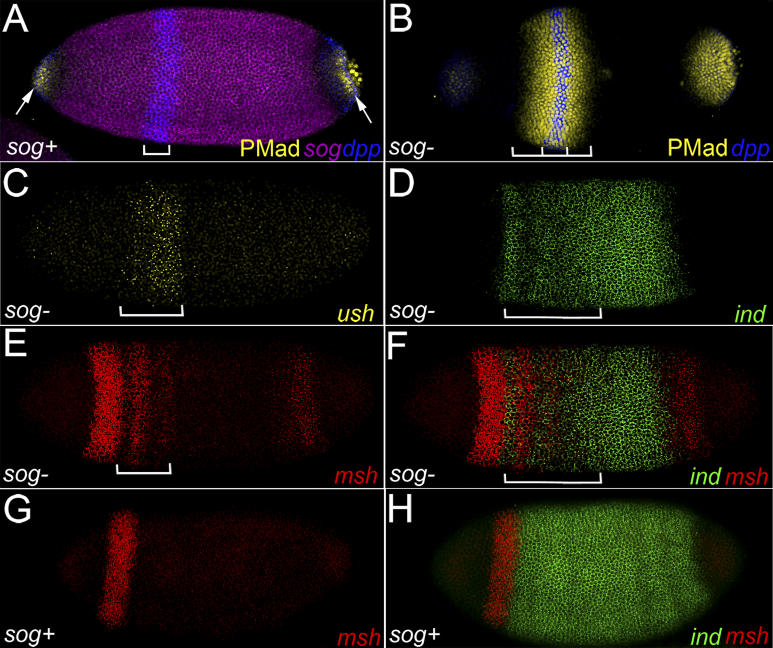
Threshold-Dependent Repression of ind and msh in Lateralized Embryos(A) sog (purple), dpp (blue), and pMAD (yellow) expression in a lateralized embryo carrying st2-dpp. Note that there is no activation of pMAD in the central stripe of dpp expression. pMAD activation at the poles (arrows) serves as a positive control for the staining.(B) sog (absence of purple), dpp (blue), and pMAD (yellow) expression in a sog− lateralized embryo carrying st2-dpp. The domain of pMAD activation (long bracket) extends considerably beyond the narrow stripe of dpp expression (short bracket).(C–F). Expression of ush (yellow), ind (green), and msh (red) in a sog−; st2-dpp lateralized embryo derived from gd
7
sog
U2/gd
7
; dl
1/+; Tl
3/+ mothers crossed to yw; st2-dpp males.(C) ush, which serves as a convenient marker for BMP activation, is induced in a domain (bracket) that is slightly broader than that of st2-dpp.(D) ind expression is repressed in a graded fashion along the AP axis extending approximately 20 cell diameters posterior to st2-dpp (bracket).(E) msh expression is activated in a pattern complementary to that of ind (bracket). This pattern exhibits modulation along the AP axis that is similar to the pattern of msh activation in wild-type embryos (see Figure 1D and 1E).(F) Merge of ind and msh expression patterns shown in (D and E) (bracket as in [D]). The restriction of msh expression to cells with very low levels of ind suggests that only modest levels of ind are necessary to repress msh expression.(G and H) Expression of ind (green), and msh (red) in a sog+; st2-dpp lateralized embryo. These embryos are siblings of the embryos described above in (C–F). ush expression is absent in this embryo.(G) msh expression is restricted to a narrow anterior stripe as it is in the absence of the st2-dpp element (compare with Figure 1H).(H) Merge of msh and ind expression showing that these gene expression domains are complementary (compare with Figure 1I).